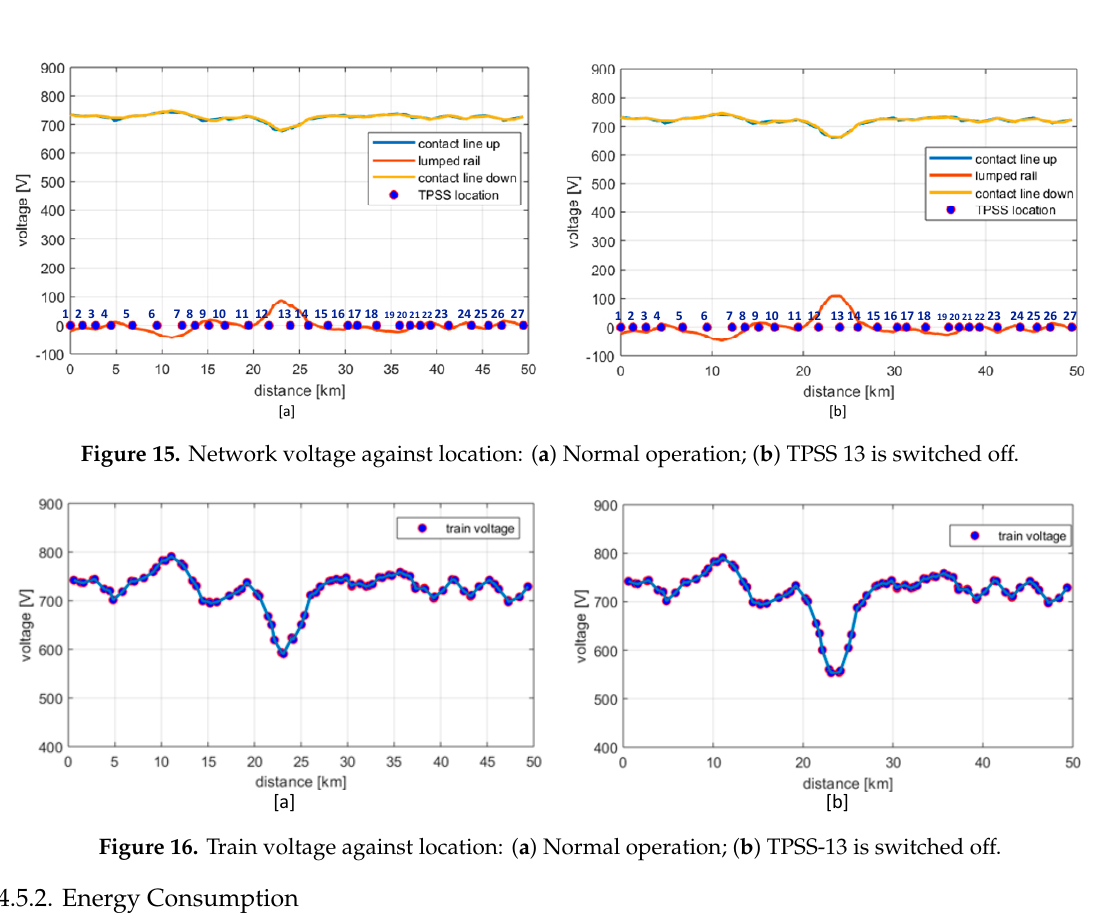
Figure 17. Energy consumption of substations with various outage modes. 4.6. Results with a Short Circuit In this section, the simulation results are studied when a short-circuit fault occurs at 26 km between TPSS-14 and TPSS-15. The short circuit resistance is 0.1 Ω , which short connects the contact line up and the earth. Figure 18 shows the network voltage when a short circuit occurs. The potential